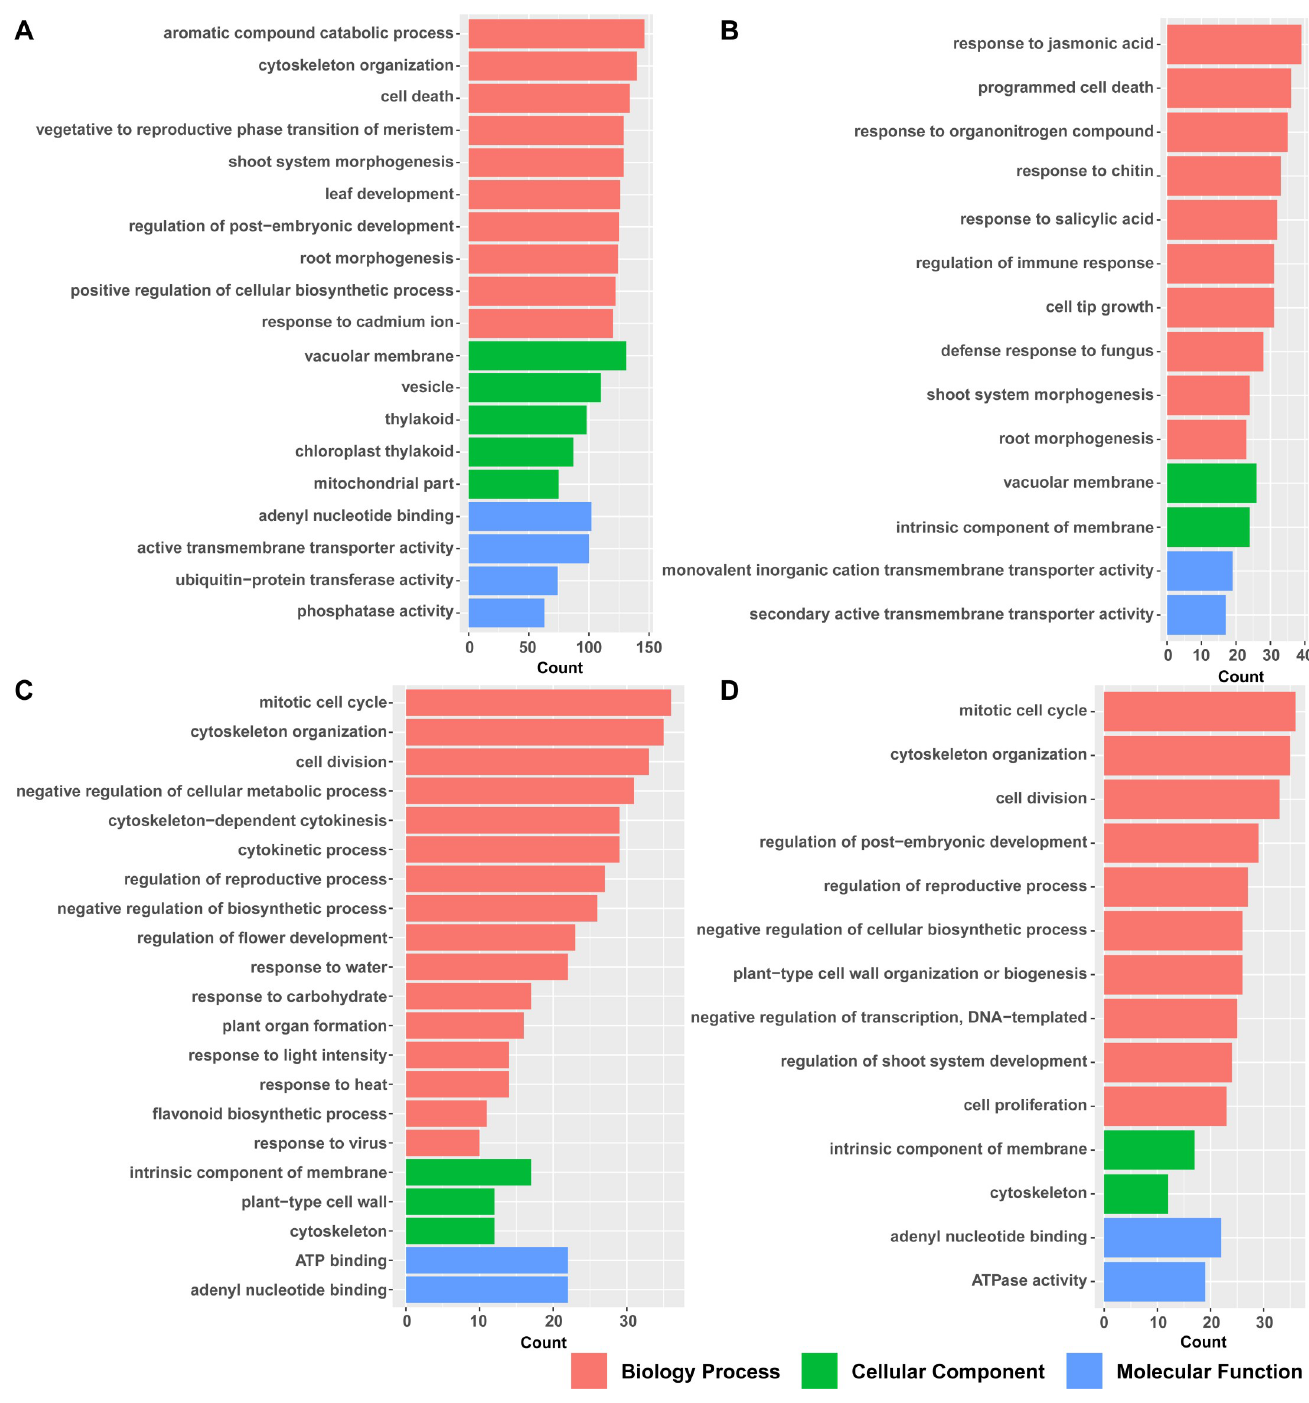
Fig 3. GO analysis between developmental stages in blueberry. (A) S3/S2; (B) S4/S3; (C) S5/S4; (D) S6/S5. S2, S3, S4, S5, and S6 represent flower bud, initial flower, bloom flower, pad fruit, and cup fruit,